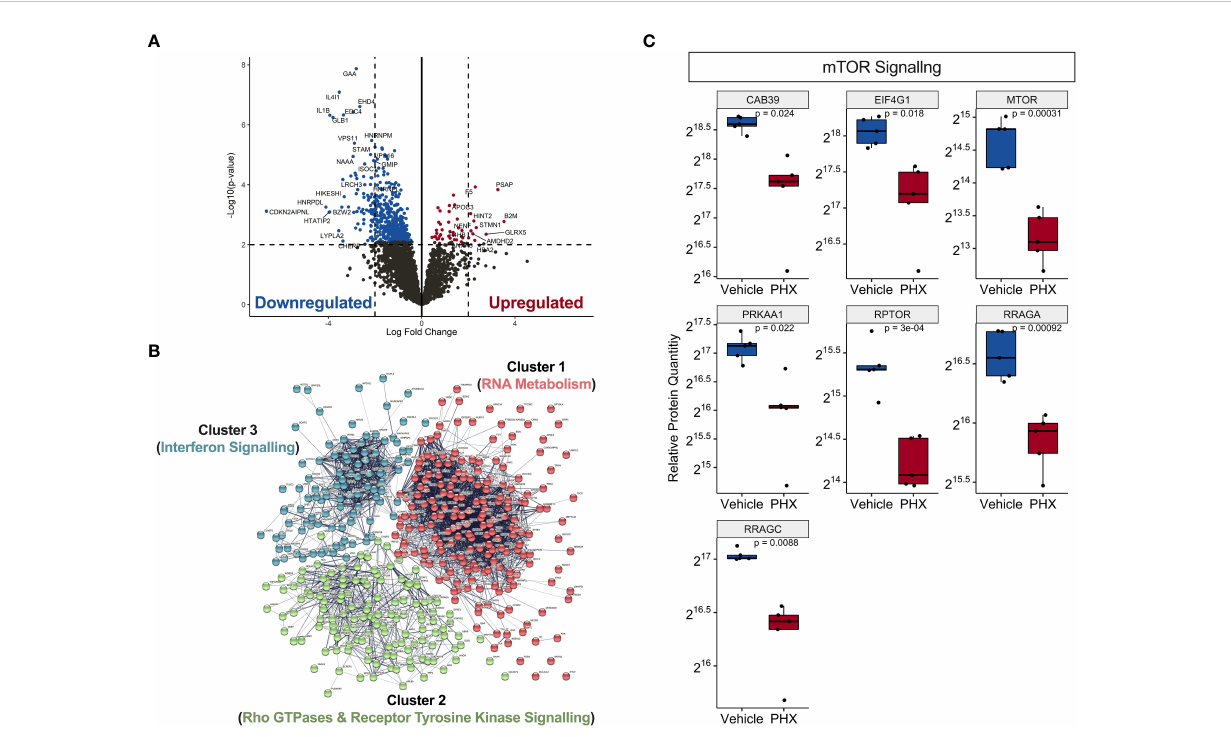
FIGURE 4 Proteomic analysis on PHX treated M1 macrophages reveal downregulation in immune signalling and RNA metabolism. (A) Volcano plot showing statistically signi fi cant upregulated (red) and downregulated (blue) proteins in 5 m M PHX treated M1 macrophages. (B) Network analysis based on protein-protein interactions (PPI) of 433 signi fi cantly downregulated proteins in PHX treated M1 macrophages. The k-means clustering identi fi ed 3 clusters with distinct Reactome Knwoledgbase pathway associated proteins. (C) Box plot comparing relative protein expression of identi fi ed mTOR signalling proteins between vehicle or PHX treated M1 macrophages. Student ’ s unpaired